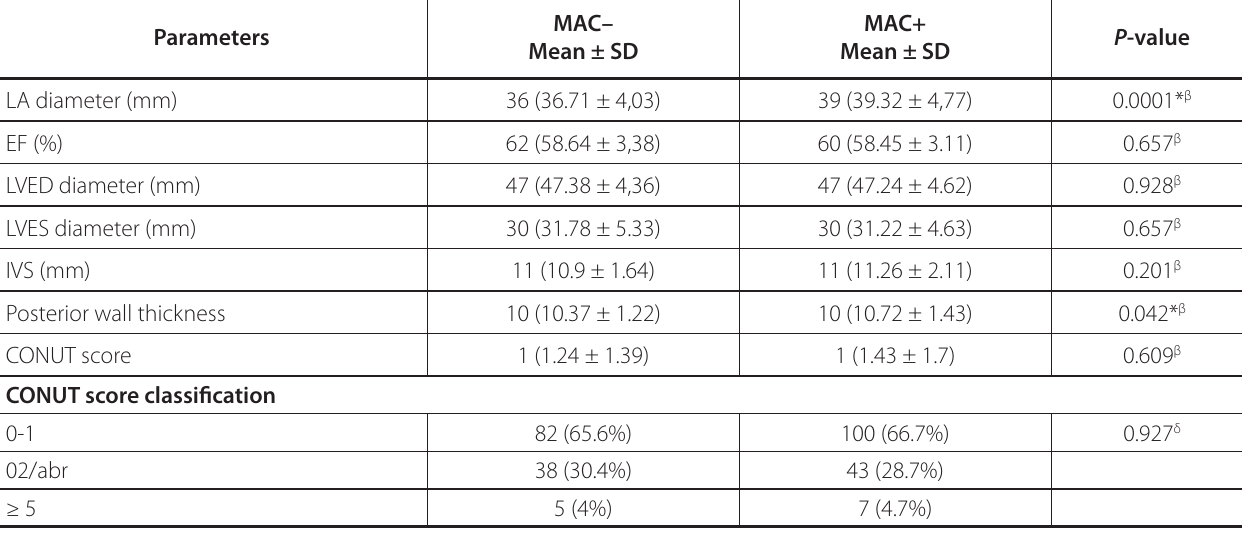
Table 2 . Echocardiography findings and CONUT score.